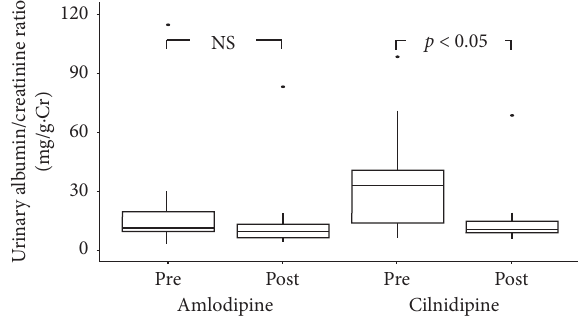
Figure 4: Changes in the urine albumin-to-creatinine ratio before and after the treatment. After 6 months of treatment, the urine albumin- to-creatinine ratio was suppressed in the cilnidipine group but not the amlodipine group.